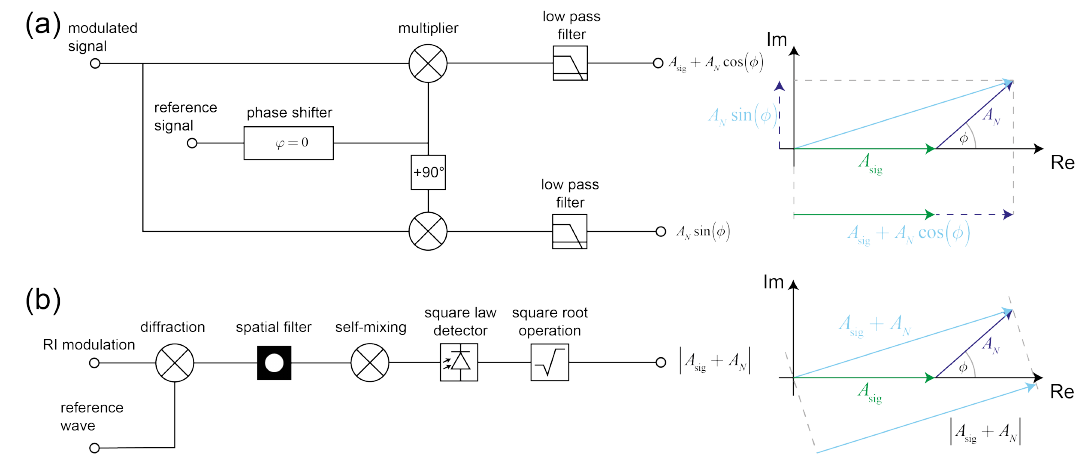
Figure 5. Difference between phase lock-in and pure frequency lock-in ( a ) A phase lock-in requires a reference signal with a fixed phase relationship to the signal. By mixing the signal with the reference and a 90 ◦ shifted reference one can obtain the in-phase and quadrature components of the resulting phasor. This allows both magnitude and phase of the resultant to be determined. ( b ) A frequency lock-in such as a diffractometric biosensor loses the phase information because only the square magnitude of the resultant phasor can be detected (square law